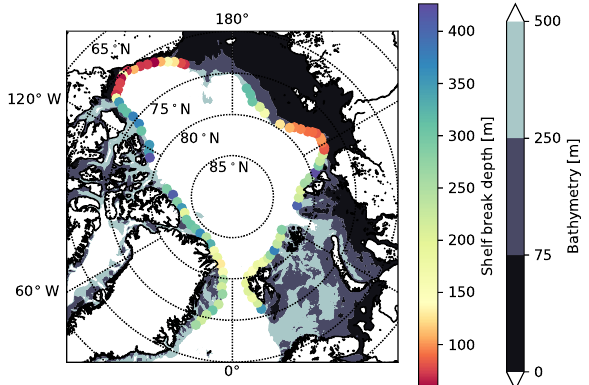
Figure 2. Depth of the Arctic shelf break extracted from the IBCAO V3 bathymetry of the Arctic Ocean (Jakobsson et al., 2012), exclud- ing only the Saint Anna Trough and the Chukchi Borderland. Most visible are the continental shelf off Alaska and the westernmost part of the Canadian shelf, where Carmack and Chapman (2003) con- ducted their study and upwelling has been frequently documented, and north of the Laptev Sea. In most other areas of the Arctic Ocean, the shelf break is several hundred metres deep and therefore out of reach to interact significantly with Ekman-driven surface ocean dy- namics. For a detailed explanation of the algorithm and the com- puter code used to extract shelf break depths, see the Supplement.